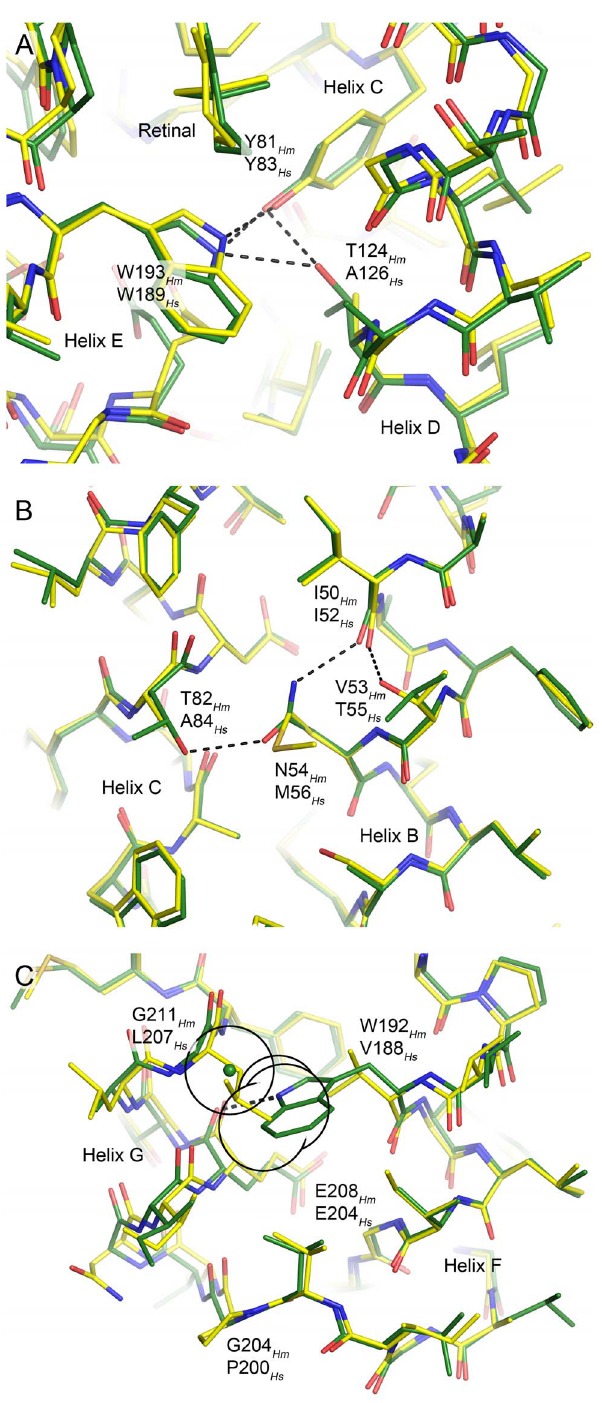
Figure 6. The novel inter-helical hydrogen bonds in Hm BRI (green) relative to HsBR (yellow). In each case, the structure alignment was done locally to emphasize the local effects. (A) The substitution A126 Hs R T124 Hm results in two novel hydrogen bonds connecting the helix D to helices C and E. (B) The coupled substitution M56 Hs R N54 Hm , A84 Hs R T82 Hm results in introduction of the hydrogen bond between the helices B and C. Interestingly, the intra-helical hydrogen bond between the I52 backbone oxygen and T55 is replaced with the hydrogen bond between the homologous I50 backbone oxygen and N54 side-chain